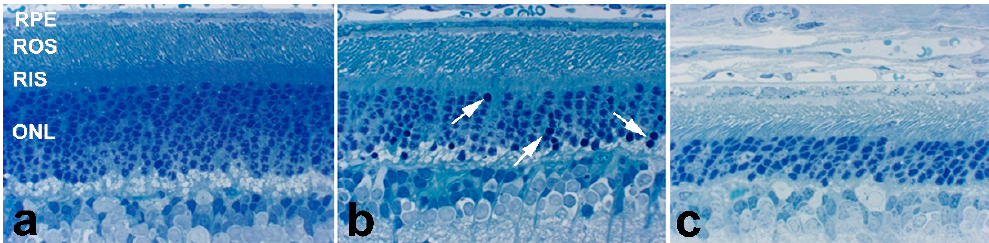
Figure 2. Histological degeneration of the retina observed in the AY9944-induced rat model of SLOS as a function of postnatal age at postnatal ( a ) one month, ( b ) two months, and ( c ) three months. Note progressive thinning of the outer nuclear layer (ONL), the appearance of pyknotic photoreceptor nuclei by two postnatal months ( arrows , panel b ), and the progressive shortening of rod outer segments (ROS). Epon embedment; toluidine blue stain.